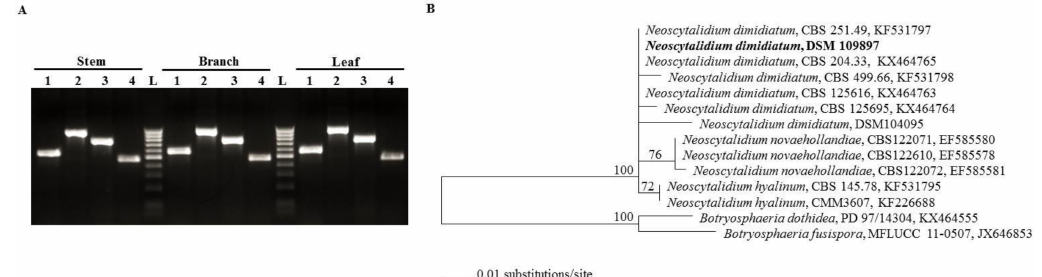
Figure 3. Molecular identification of Neoscytalidium dimidiatum. PCR amplification of specific genomic DNA regions of infected stem, branch and leaf tissues ( A ); and dendrogram showing phylogenetic relationships among N. dimidiatum (DSM 109897) identified in this study and other members of Neoscytalidium spp. prepared by the Maximum Likelihood (ML) method ( B ). In ( A ), lanes 1-4 correspond to amplifications of ITS , 28S rDNA region, TEF1- α and β -tubulin , respectively, in trunk (stem), branches and leaves. In ( B ), the ML tree was obtained from TEF α -1 sequence data. The specimens used in this study carry GenBank accession number, N. dimidiatum TEF1- α (MN447201). Numbers at the nodes are bootstrap values after 100 replicates are expressed as percentages (LnL = − 603.684353). Only values above 70% are indicated. The scale bar on the rooted tree indicates a 0.01 substitution per nucleotide position. The strain of N. dimidiatum from this report is indicated in bold. Botryosphaeria dothidea , PD 97 / 14304 (KX464555) and B. fusispora MFLUCC 11-0507 (JX646853) were used as outgroups. ITS , internal transcribed spacer ; 28S rDNA, large subunit (LSU) of rDNA; TEF1- α , translational elongation factor 1- α ;